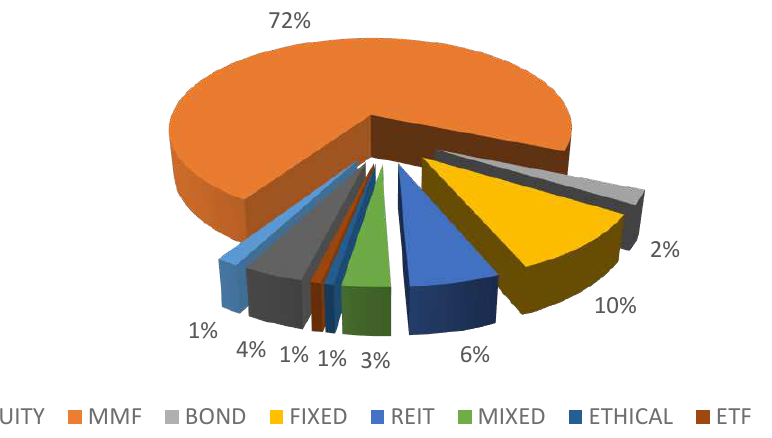
Figure 1. Distribution of investment in mutual funds in